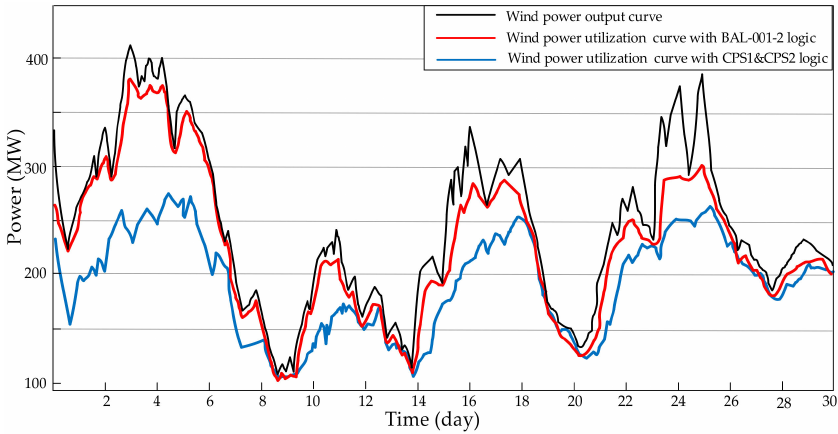
Figure 4. Wind power utilization with the two